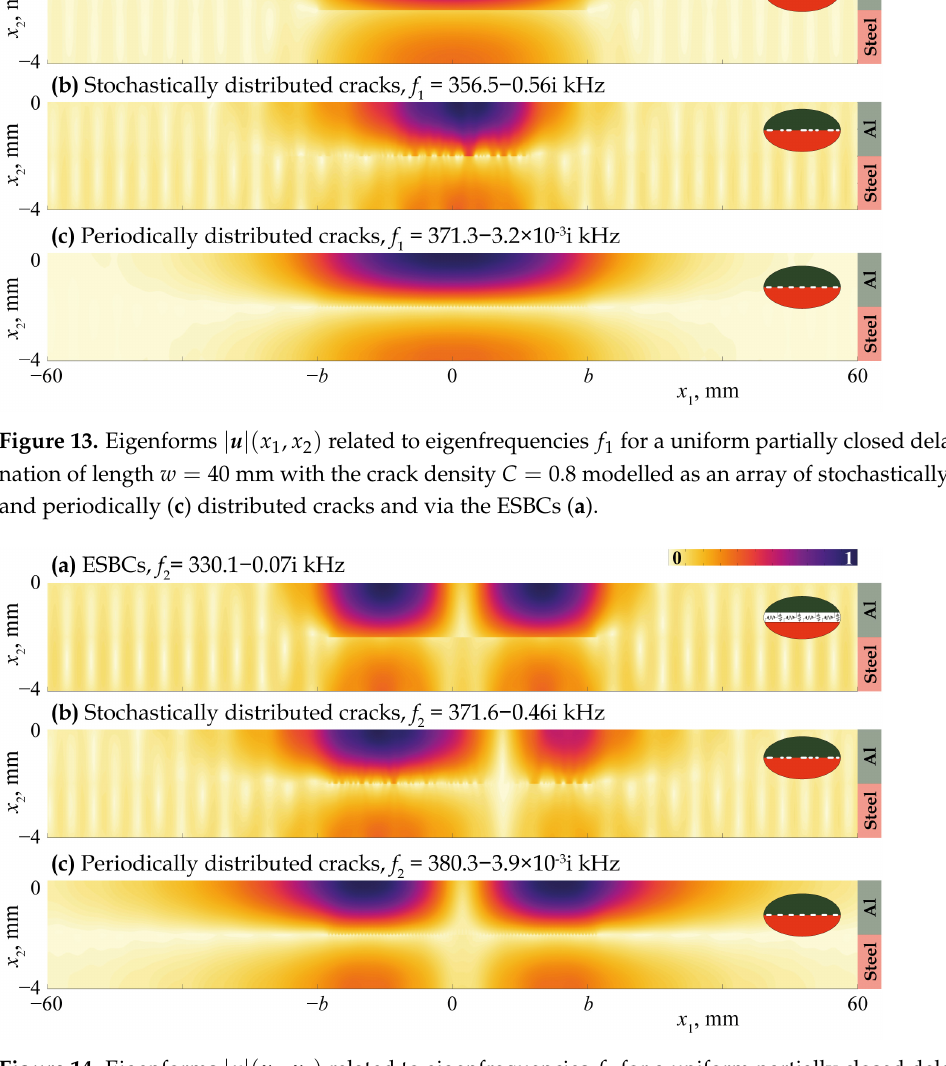
Figure 14. Eigenforms | u | ( x 1 , x 2 ) related to eigenfrequencies f 2 for a uniform partially closed delami- nation of length w = 40 mm with the crack density C = 0.8 modelled as an array of stochastically ( b ) and periodically ( c ) distributed cracks and via the ESBCs ( a ).